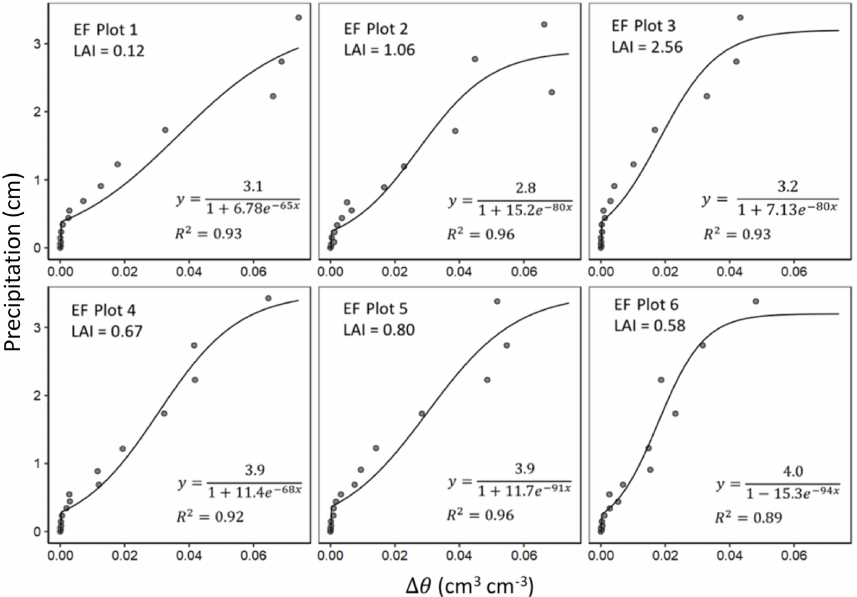
Figure 2. Binned rainfall depths versus change in soil moisture content ( (cid:49)θ ) for six plots at one of the study sites used in the study (Econfina; EF). The y intercepts of the fitted relationships were used to derive P s in Eq. (2). Note the different y -axis scale for EF Plot